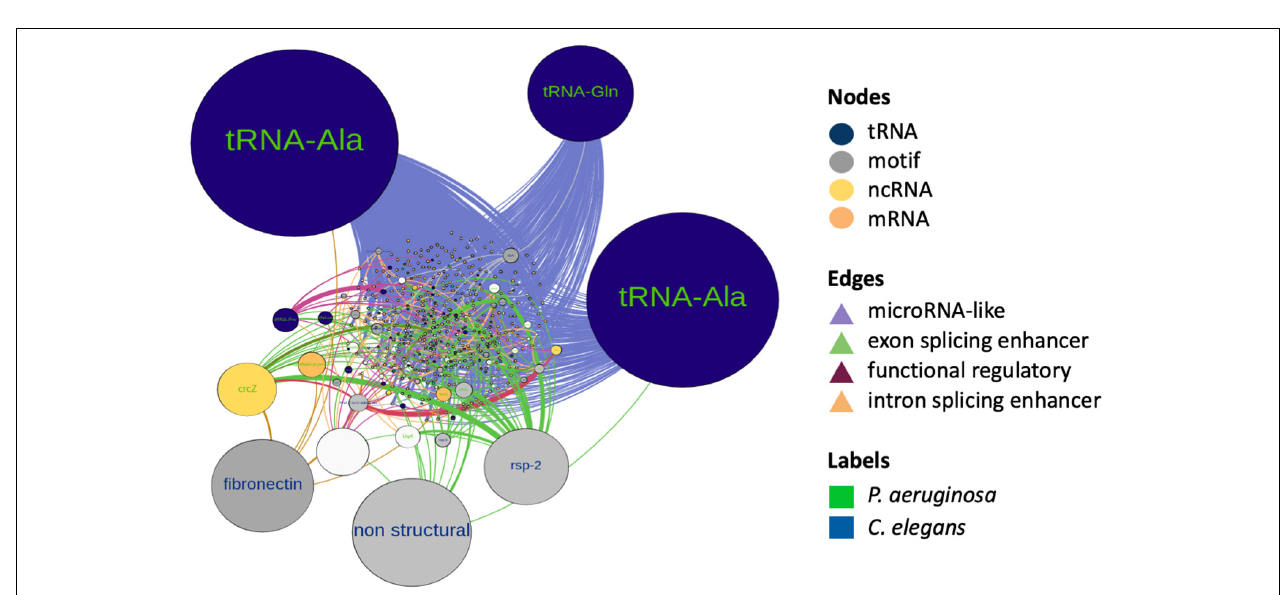
FIGURE 5 | Sankey diagram depicting the number of motifs of induced sRNAs (red) and constitutive sRNAs (blue) in the first column, motif type in the second, and specific targets in the third column. Intron and exon splicing regulatory motifs are similarly represented among induced and constitutive sRNAs. Functional RNA sequences (comprising tRNAs and sRNA P16) are exclusive from induced sRNAs.